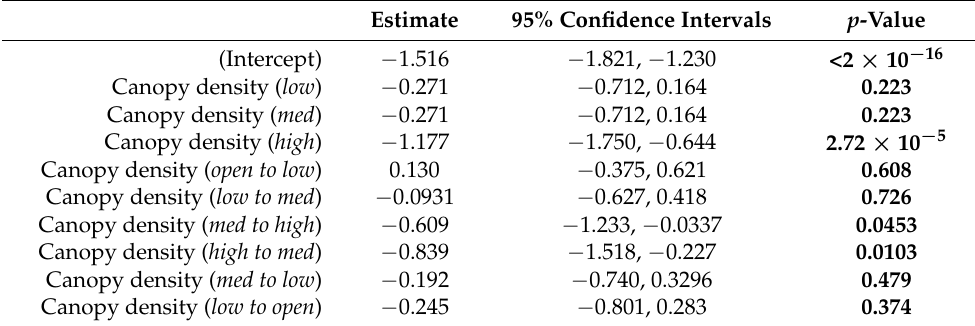
the variables camera angle and canopy density.